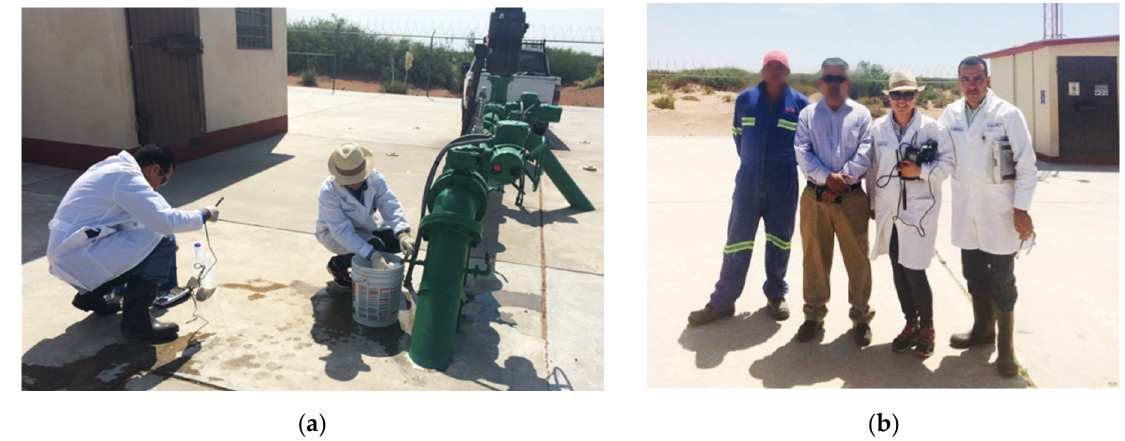
Figure 2. Sampling with JMAS, Grupo CARSO, UACJ Environmental Laboratory: ( a ) sampling water in the Conejos Médanos from JMAS well set with the UACJ Environmental Laboratory, ( b ) sampling team members of CARSO, JMAS, this study, and UACJ Environmental Laboratory.